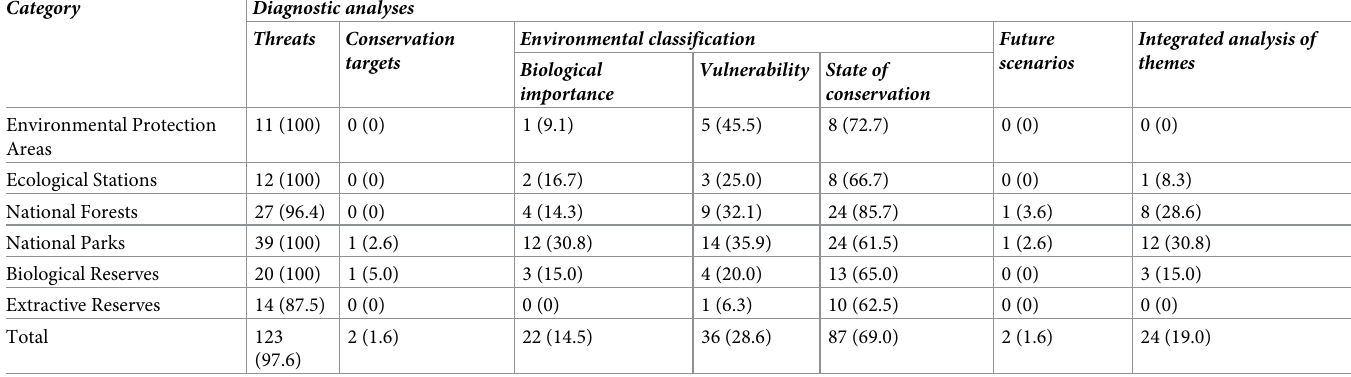
Table 2. Number and percentage (in parentheses) of analyses performed in environmental diagnoses of management plans by category of Protected Areas.